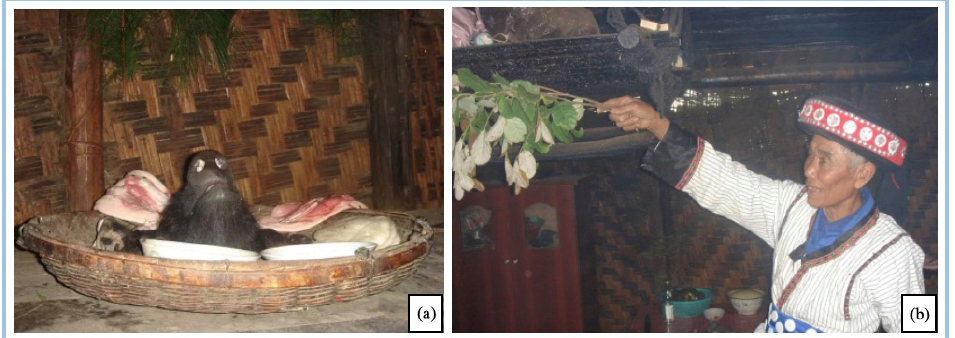
Figure 7. The Lisu people worship their ancestors at the Kuoshi Festival. ( a ) Ritual objects; ( b ) village priest clearing houses with Lithocarpus branches while blessing. (Photo by Nujiang Lisu Autonomous Prefecture Culture and Tourism Bureau, July 2020, Photographed in Zhongyuan